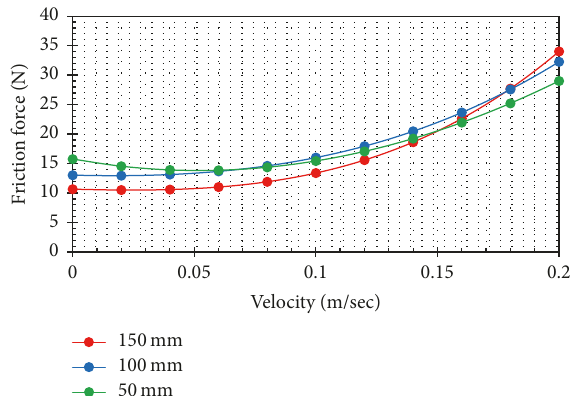
Figure 12: Simulation time history of displacement for the friction functionofmeasuringdisplacementandindividualbestfitandover- all best fitting function (WD40 whipped with initial displacement of 47.98